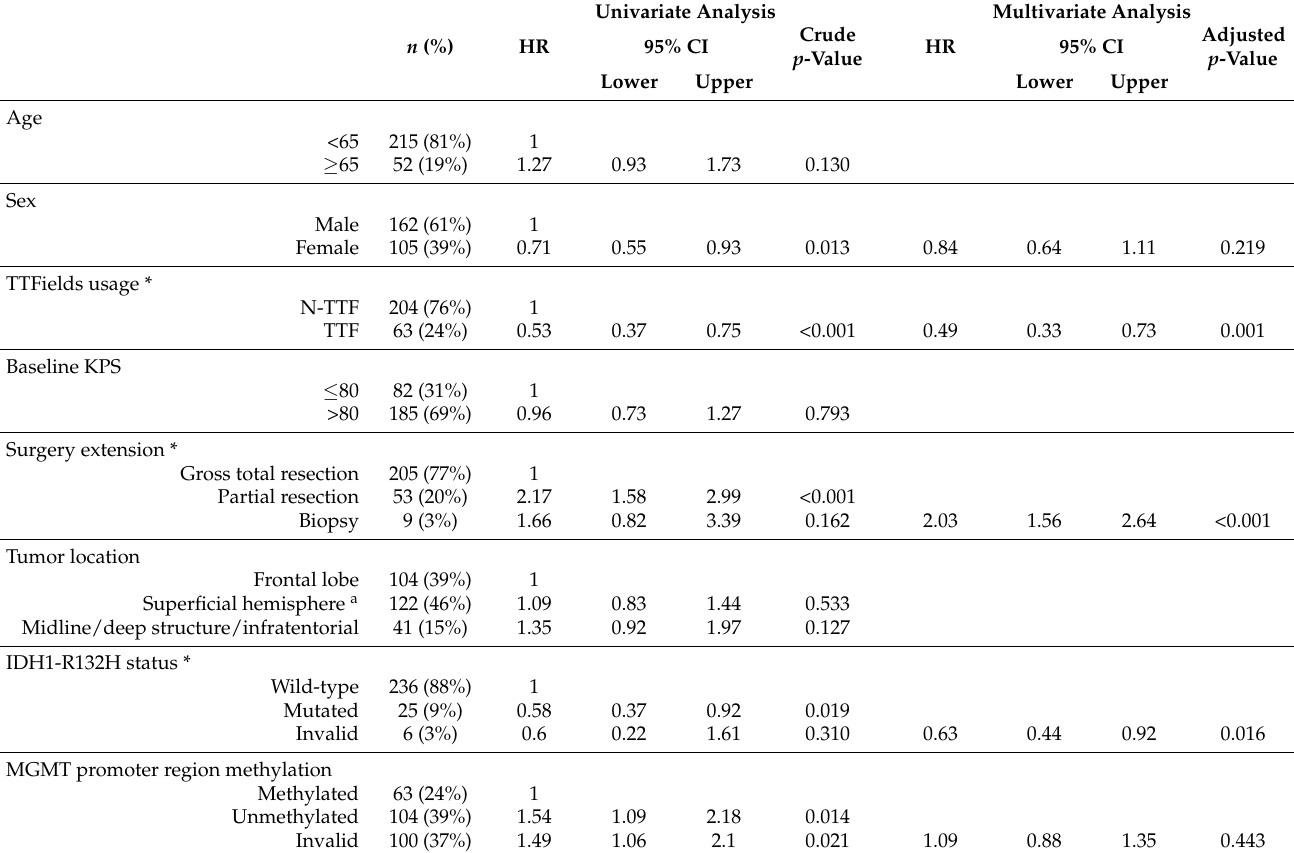
Table 2. Univariate and multivariate analyses of progression-free survival (PFS) in GBM patients. Univariate Analysis